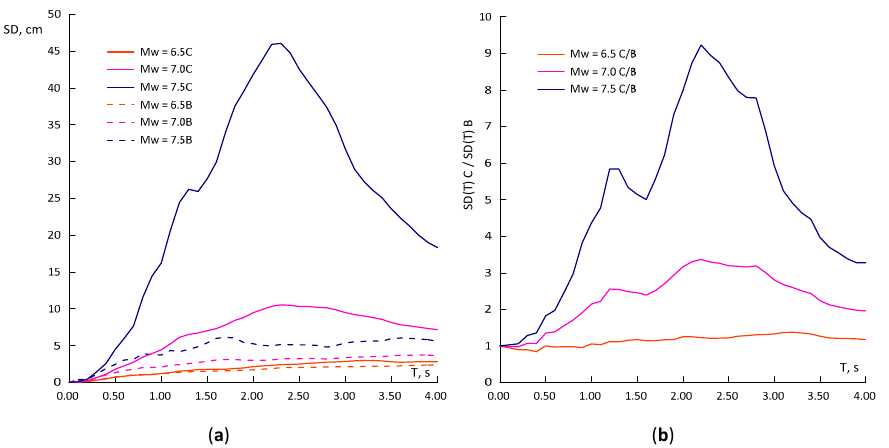
Figure 8. Displacement demand, function of magnitude and soil conditions. ( a ) Spectral displacement function of magnitude, D epi = 100 km, type B soils represented with dashed lines, type C soils with continuous lines; ( b ) the ratio between displacement on ground type C and displacement on ground type B, SD(T) C /SD(T) B , D epi = 100 km.